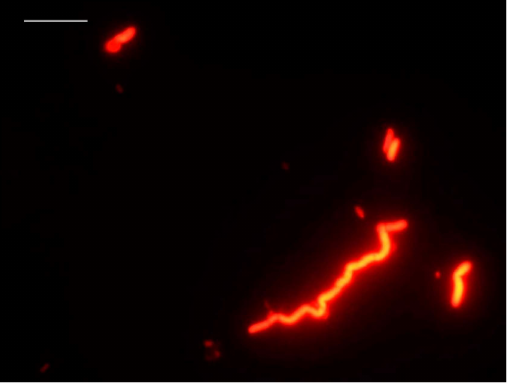
Figure 4. Detection of viable V. parahaemolyticus cells by DVC-FISH at a concentration of 10 2 cells/mL. (bar: 10 µ m).